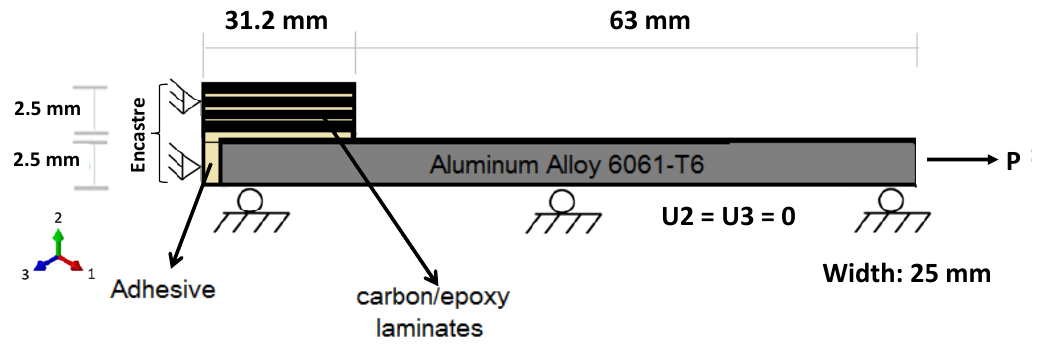
Figure 12. Schematic representation of quarter specimen with boundary conditions. Table 5. Isotropic properties of aluminum and carbon fiber.